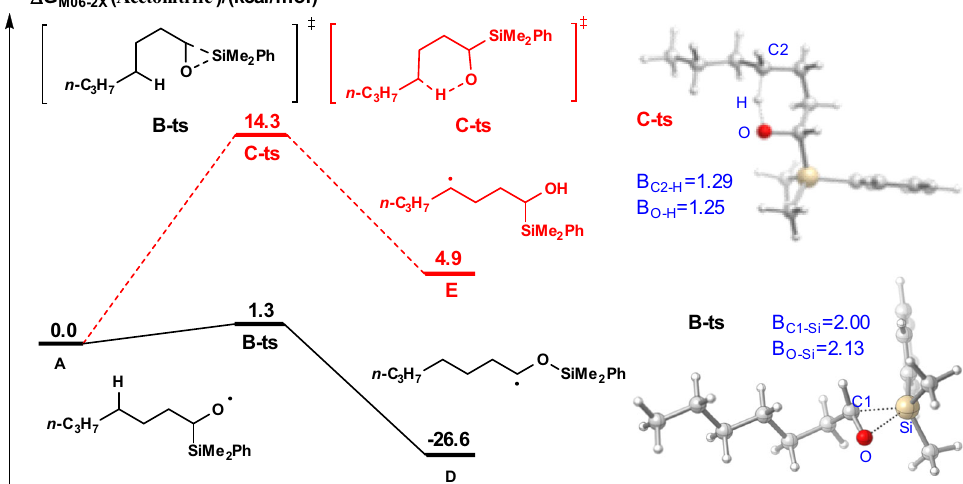
Fig. 5 Free-energy pro fi le of the pathways for 1,2-SiT vs 1,5-HAT. The energies are in kcal/mol and represent the relative free energies calculated with the DFT/M06-2X method in MeCN. The bond distances are in